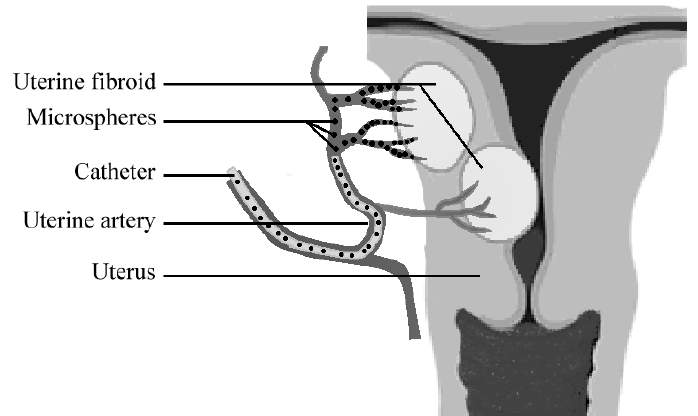
Figure 4. Scheme of uterine artery embolization (UAE). An angiographic catheter is introduced via the femoral artery, through a small opening in the groin. Microspheres are injected into the uterine artery that is supplying the fibroids. The microspheres subsequently block these arteries and induce shrinkage of the